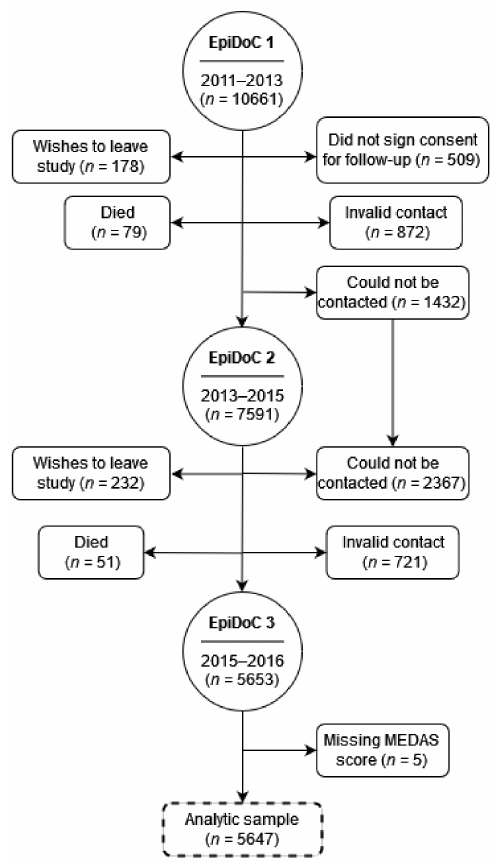
Figure 1. Flowchart of EpiDoC cohort. Participants that could not be contacted in EpiDoC 2 were not excluded from the study and the same contact was attempted at EpiDoC 3. Only data from EpiDoC 3 were used for the analytic